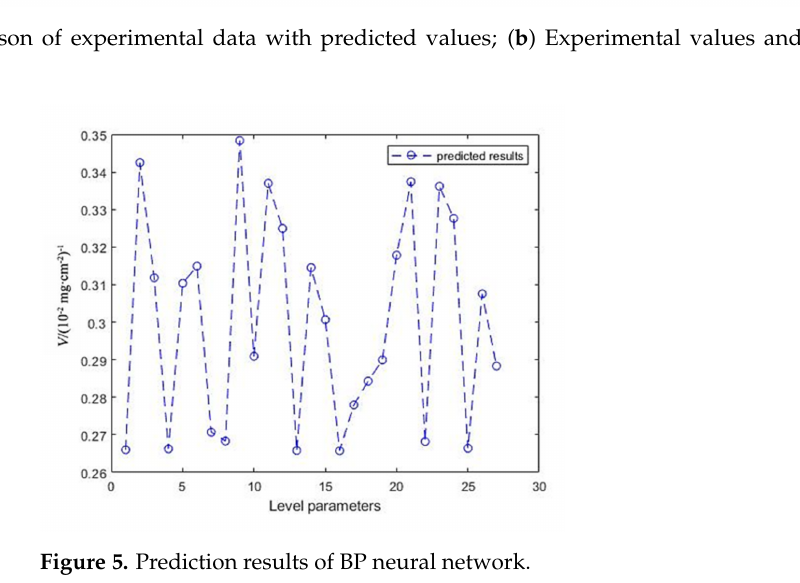
Figure 5. Prediction results of BP neural